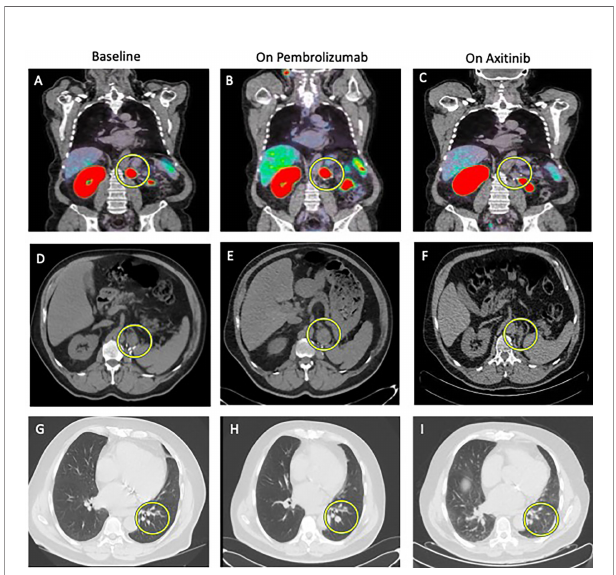
FIGURE 2 | Comparison between baseline imaging and on-treatment imaging. 68 GaPSMA-PET at baseline (A) and at 8-week on pembrolizumab alone (B) showing absence of metabolism decrease (yellow circle) and at 16-week on axitinib alone (C) showing disappearance of metabolism (yellow circle). Other metabolic lesion was not cancer lesion, but normal kidney (left) and physiological bowel metabolism (right on the picture). Abdominal CT Scan at baseline (D) , at 12-week (E) showing increase in size of the lesion at the nephrectomy site (yellow circle) and at 16-week (F) showing partial response. Thoracic CT Scan at baseline (G) , at 12-week (H) showing increase in size of pulmonary lesions (yellow circle) and at 16-week (I) showing partial